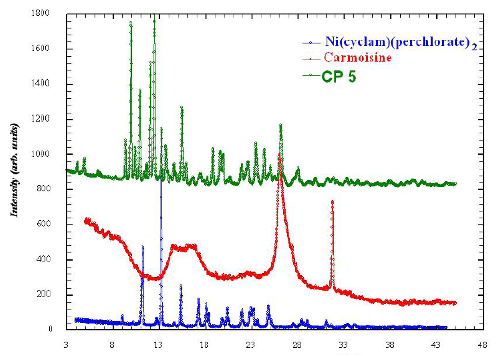
Figure 4. DSC-TGA curves for{[Ni II (cyclam)](carmoisine dianion)} n ( 5